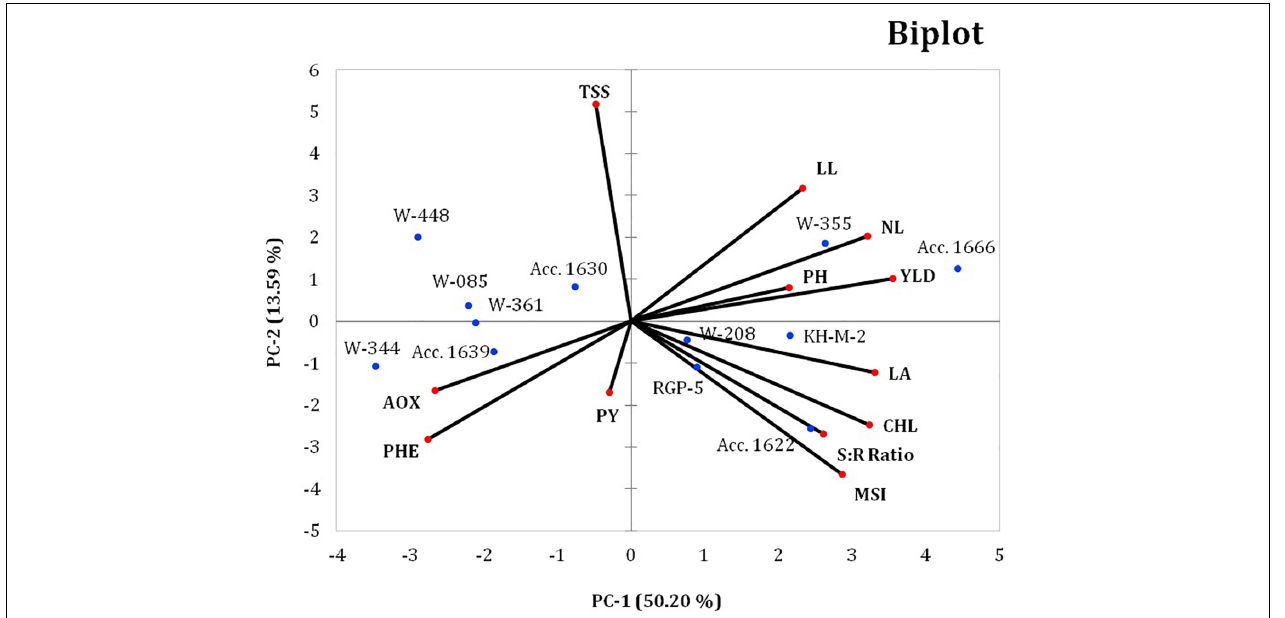
FIGURE 3 | Principal component (PC) iplot for the 12 different traits of 12 contrasting onion genotypes under waterlogging conditions. PH, plant height; NL, number of leaves per plant; LL, leaf length; LA, leaf area; PHE, total phenol; AOX, antioxidant activity; PY, pyruvic acid; TSS, total soluble solids; CHL, total chlorophyll; MSI, membrane stability index; YLD, bulb yield; R:S, root-to-shoot